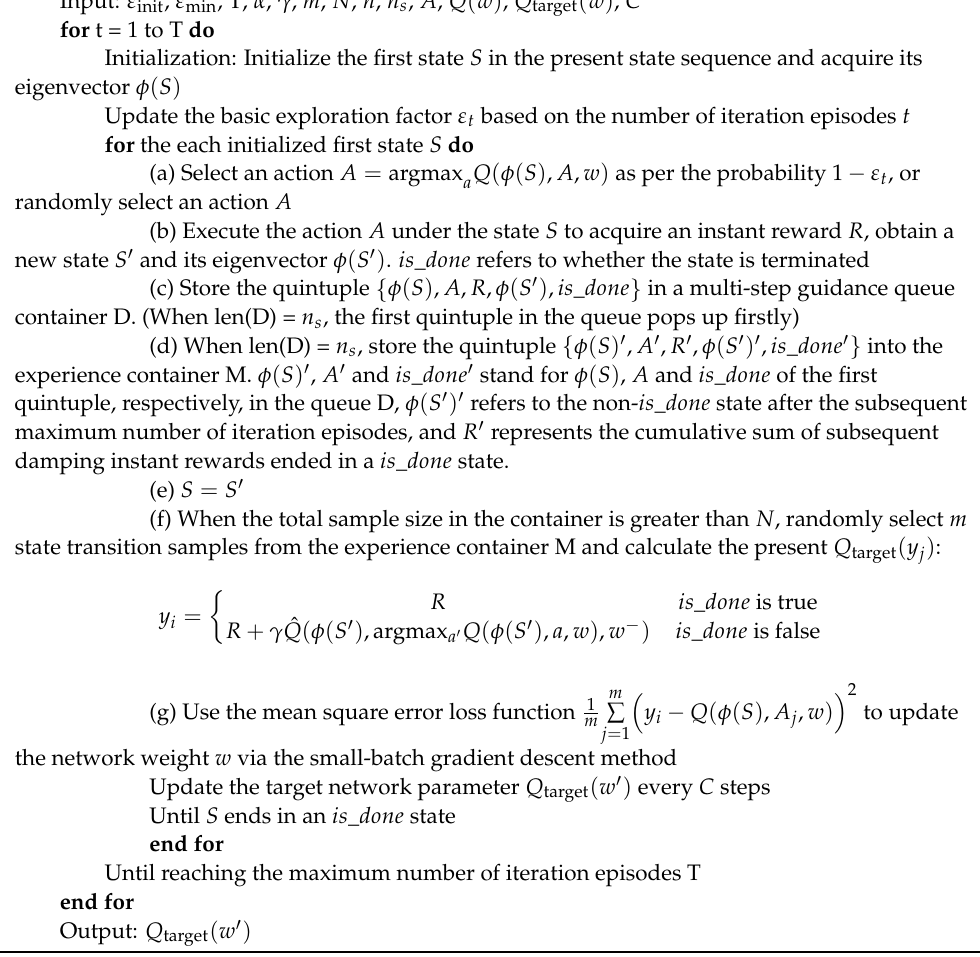
Algorithm 3: Pseudo form of the MS-DDQN